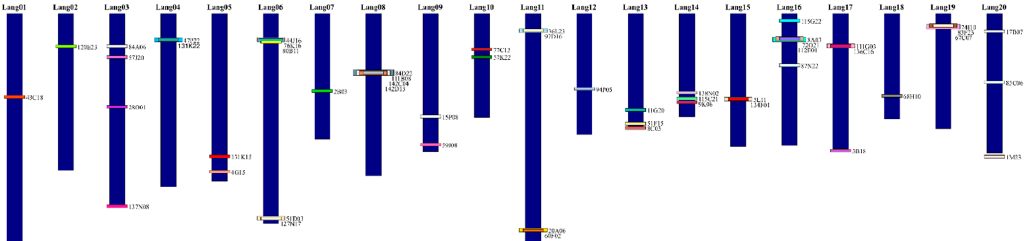
Figure 1. Fluorescence in situ hybridization verification of BAC localization in chromosomes of L. angustifolius . ( A ) BAC 43C18 (red signals)—Lang 01 and BAC 51F15 (green signals)—Lang 13. ( B ) BAC 2B03 (red)—Lang07 and 74I10 (green)—Lang19. ( C ) 67C07 (red)—Lang19 and 74I10 (green)—Lang19. ( D ) BAC 11G20 (red)—Lang13 and BAC 51F15 (green)—Lang13. ( E ) BAC 51F15 (red)—Lang13 and 8C03 (green)—Lang13. ( F ) 17B07 (red)—Lang20 and 1M23 (green)—Lang20. Chromosomes were stained with DAPI (blue). Scale bars = 5 µm.